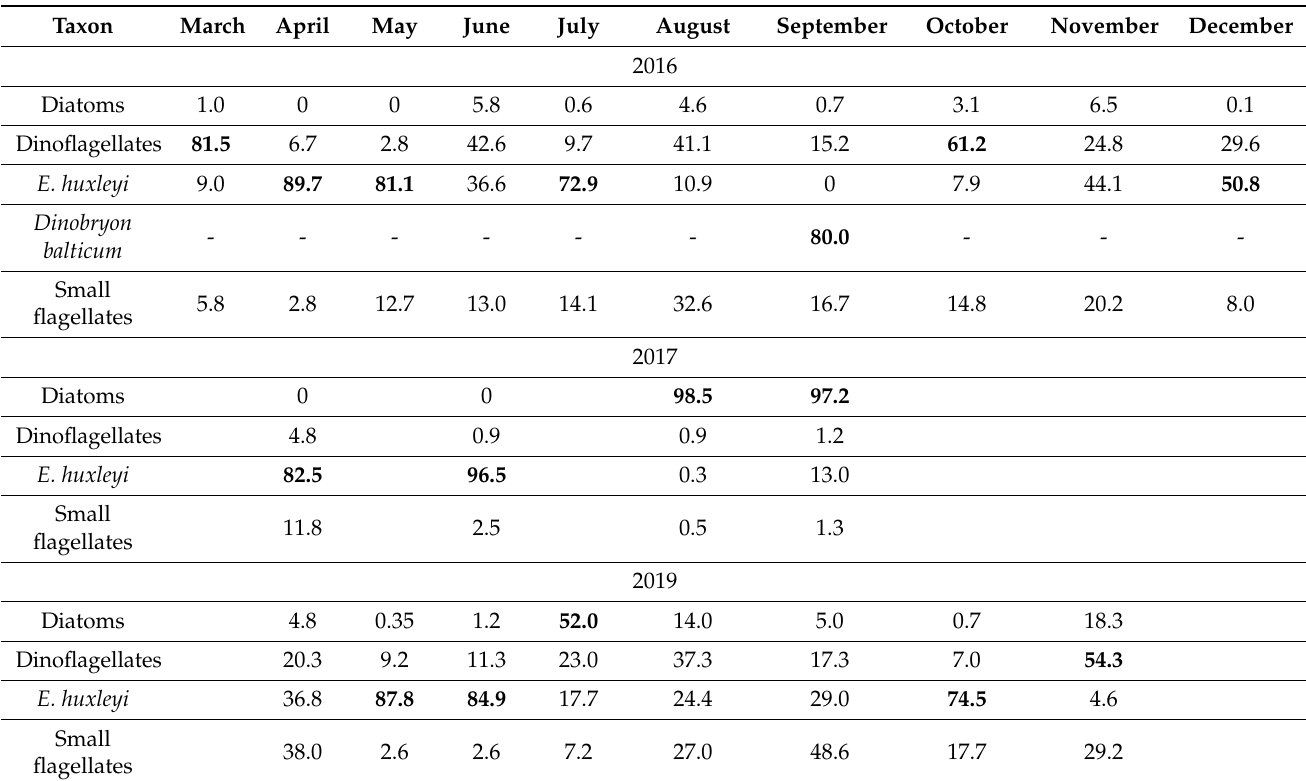
Table 4. Contribution (%) of diatoms, dinoflagellates, coccolithophores, and chrysophytes to the monthly maximum of the total phytoplankton biomass in 2016, 2017, and 2019. Values in bold show predominance of single